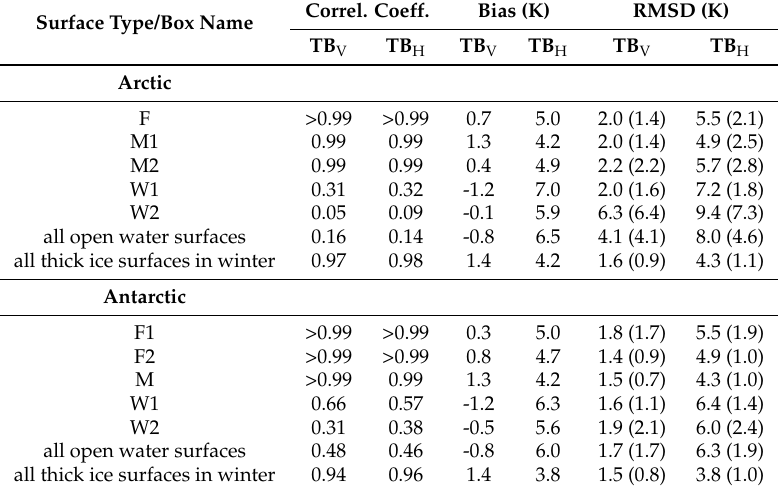
Table 4. Statistics of brightness temperature comparison between SMOS and SMAP over the boxes indicated in Figure 7: correlation coefficient, bias, root mean squared difference (RMSD) (and RMSD after bias adjustment, see text) for daily values over the 2-year period from 1 April 2015 to 31 March 2017. Correl. Coeff. Bias (K) RMSD (K) Surface Type/Box Name TB V TB H TB V TB H F >0.99